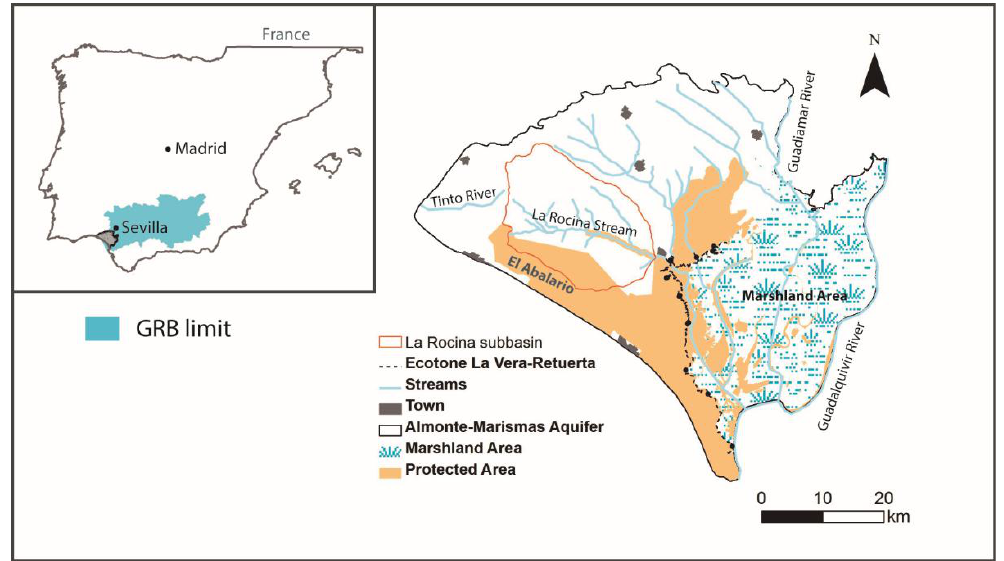
Figure 1. Location of the Almonte-Marismas Aquifer and locations studied. The Guadalquivir River Basin (GRB) limit is also shown.